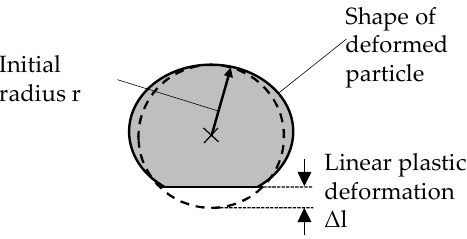
Figure 2. Definition of the determined linear plastic deformation (Adapted from [18].)